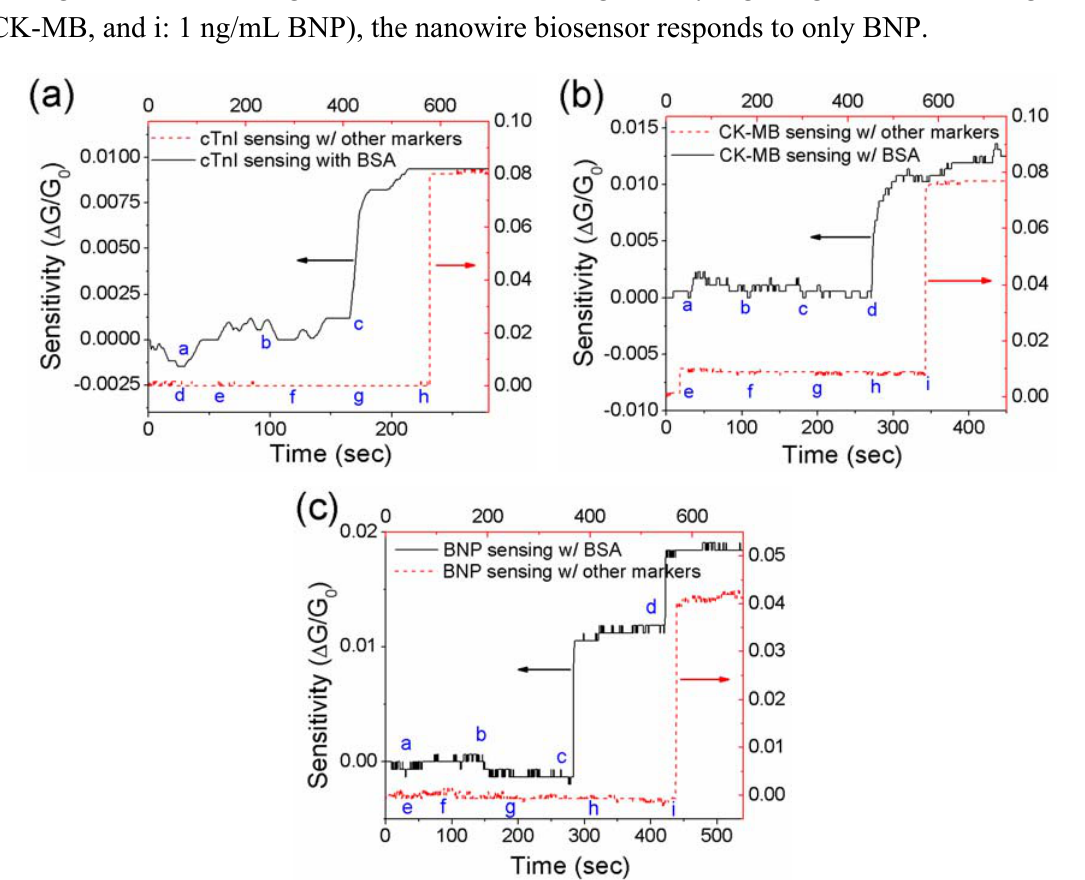
Figure 4. Specificity tests of the single PANI nanowire biosensor in the presence of non-target proteins. ( a ) For detection of cTnI (a: PBS, b: 1 ng/mL BSA, c: 500 fg/mL cTnI, d: PBS, e: 1 ng/mL Myo, f: 1 ng/mL CK-MB, g: 1 ng/mL BNP, and h: 1 ng/mL cTnI),